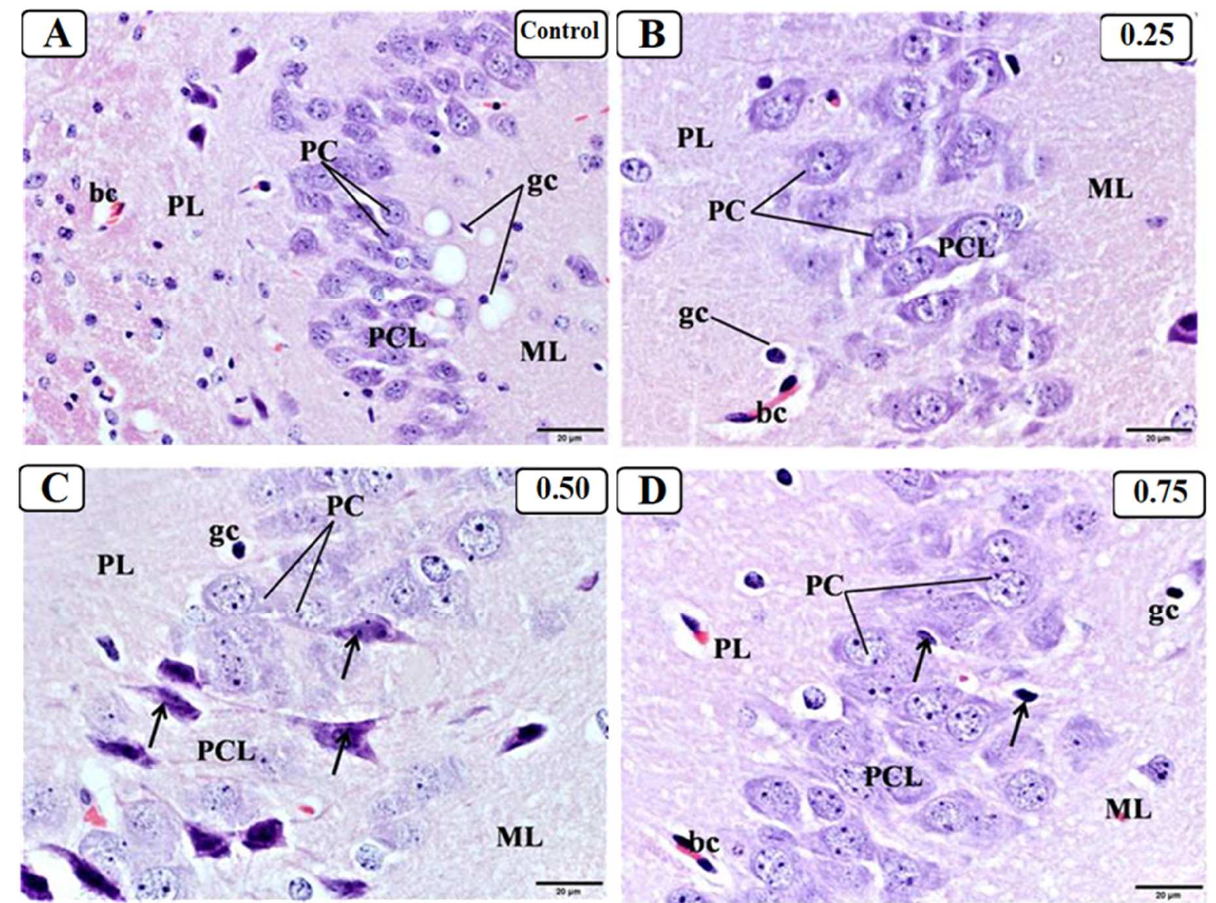
Figure 7. Representative photomicrographs of the CA3 region. ( A ) The control group reveals three regularly arranged layers; the polymorphic layer (PL), pyramidal cell layer (PCL), and molecular layer (ML). Pyramidal cells (PCs) are large with vesicular nuclei, prominent nucleoli, and scant cytoplasm. The PL and ML contain glial cells (gc) and blood capillaries (bc). ( B ) Regularly arranged three layers; PL, PCL and ML in LPS 0.25 treated group with normal appearance of PC. ( C ) Many degenerated PCs (arrow) in the PCL of LPS 0.5 treated group, which appeared condensed with pyknotic nuclei. ( D ) Some degenerated PCs (arrow) in the PCL of LPS 0.75 treated group, which appeared condensed with darkly stained cytoplasm and ill-defined nuclei (H&E × 400).